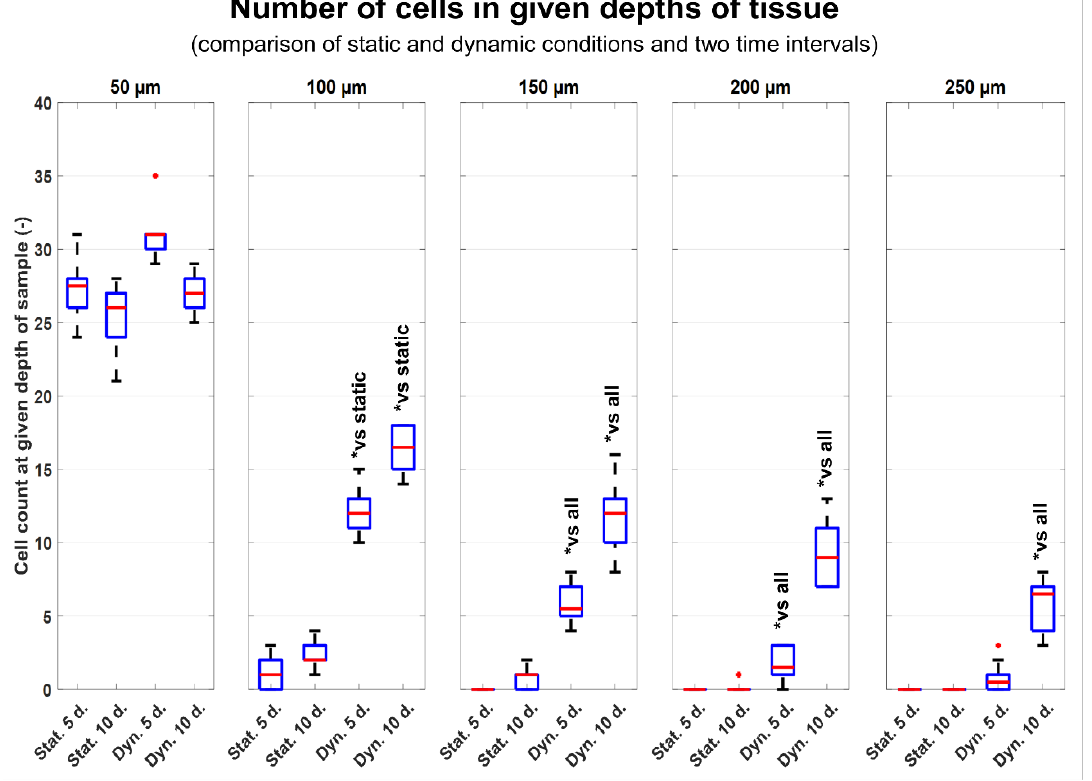
Figure 8. The number of cells in given depths of tissue in static and dynamic conditions with single side seeding. Statistical significance is for p < 0.05. Ten samples were taken for every type of cultivation and time interval. Each of the samples was sliced to 50 µm depth regions where cell numbers were counted. Red lines represent the median values; blue boxes 1st and 3rd quartiles; whiskers are the minimum and maximum; and the red circles are outliers.